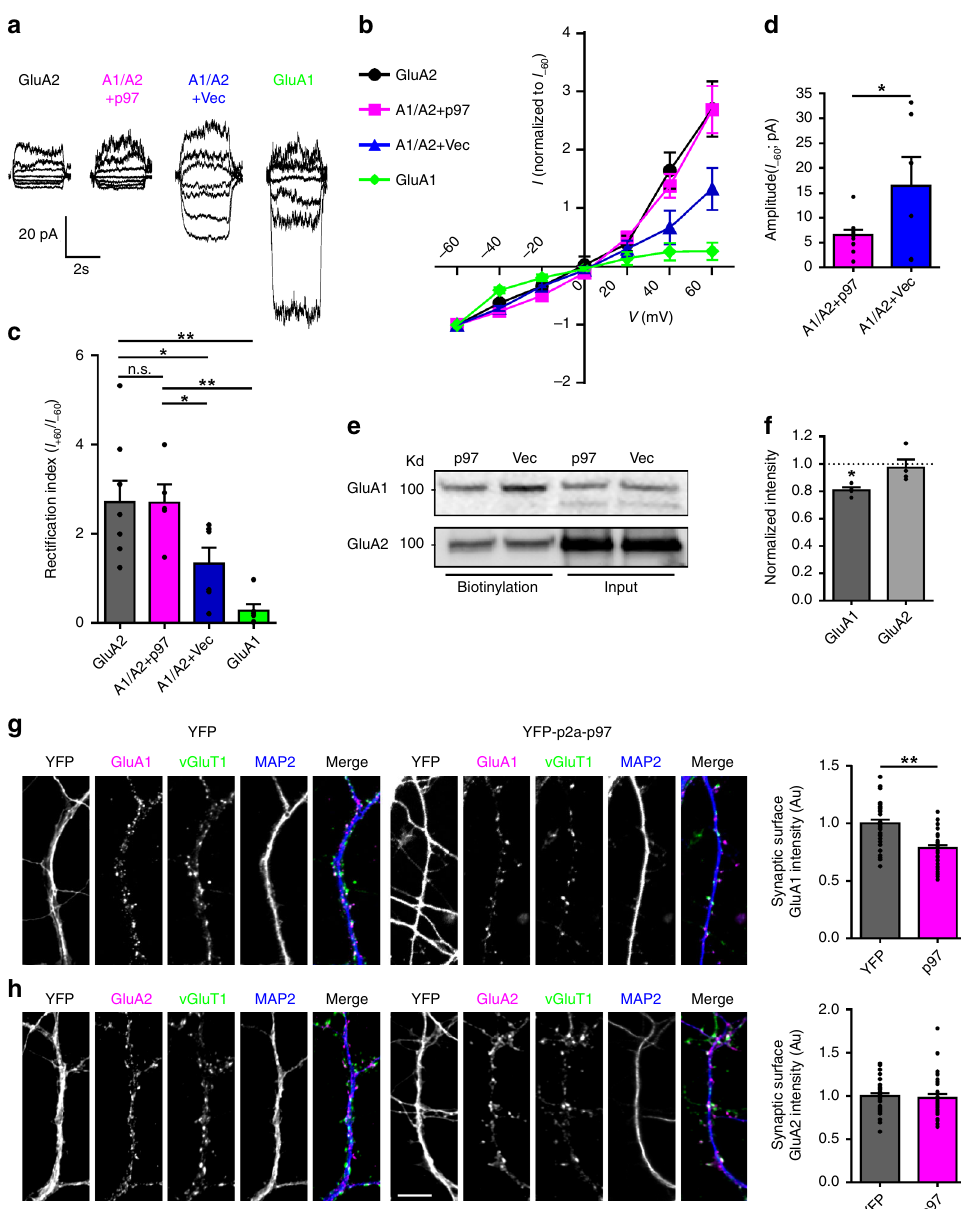
Fig. 2 p97 regulates subcellular localization of GluA1-homo AMPARs. a – d HEK293 cells were transfected with GluA1, GluA2, GluA1/GluA2 plus p97 (A1/ A2 + p97), or GluA1/GluA2 plus control vector (A1/A2 + Vec). AMPAR-mediated whole-cell currents were induced by fast application of kainite (50 μ M; to reduce receptor desensitization) while holding membrane potentials from − 60 to + 60 mV with a step interval of 20 mV. Representative traces and I – V curves are shown in ( a ) and ( b ), respectively, and recti fi cation indexes ( I + 60/ − 60 mV ) in ( c ) are quanti fi ed from recordings in ( b ) (GluA2: n = 8 cells; A1/ A2 + p97: n = 5 cells; A1/A2 + Vec: n = 6 cells; GluA1: n = 6 cells; F = 8.843, p = 0.0006, one-way ANOVA; * p < 0.05, ** p < 0.01, post hoc test). d Bar graphs of the peak current amplitude recorded at the holding potential of − 60 mV show that overexpression of p97 reduces whole-cell currents (A1/A2 + p97: n = 10 cells; A1/A2 + Vec: n = 6 cells; * p < 0.05, two-tailed t test). e , f Immunoblots sequentially probed for GluA1 and GluA2 following surface biotinylation in HEK293 cells reveal that co-expression of p97 with GluA1 and GluA2 subunits speci fi cally reduces the surface expression of GluA1, but not GluA2, subunits ( n = 4 repeated experiments; * p < 0.05, two-tailed t test, compared with Vec). g , h Cultured hippocampal neurons were transfected with YFP or YFP-p2a-p97 (p97) at 0 DIV. Neurons were immunostained live using anti-GluA1 ( g ) or GluA2 ( h ) antibody under nonpermeable conditions at 14 DIV, followed by fi xation and immunostaining for VGluT1 and the dendritic marker MAP2 under permeable conditions. Overexpression of p97 signi fi cantly reduced synaptic surface GluA1 intensity without changing GluA2 intensity (scale bar represents 10 μ m; n = 33 cells from two independent experiments, ** p < 0.01, two-tailed t test). The error bars represent